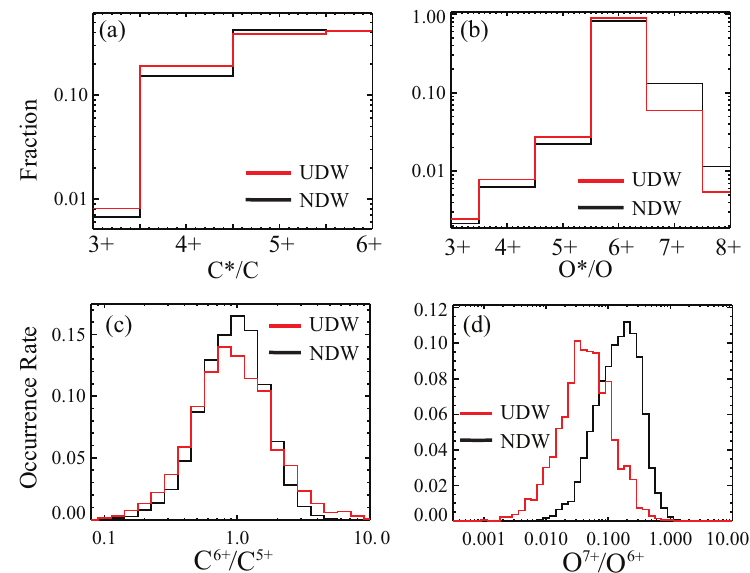
Figure 4. ( Top ( a , b )) Relative distributions of Carbon (Oxygen) charge state over total Carbon (Oxygen) abundance in UDW (red) and NDW (black). ( Bottom ) Histograms of C 6 + /C 5 + ratio ( c ) and O 7 + /O 6 + ratio ( d ) of UDW (red) and NDW (black).